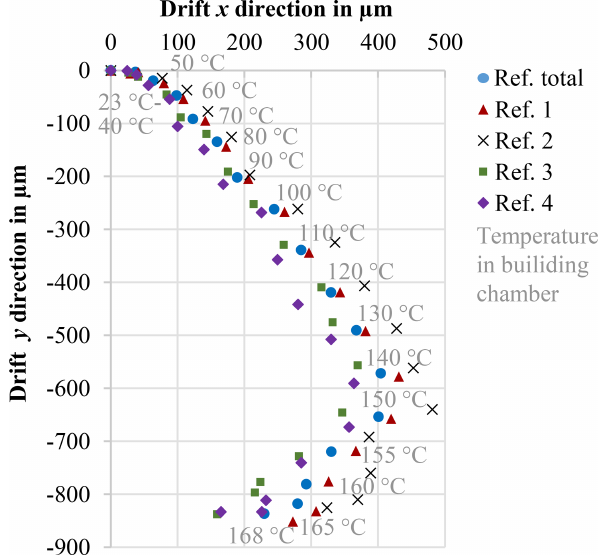
Figure 12. Thermal drift of reference system relative to the camera system (or vice versa) during heating phase.